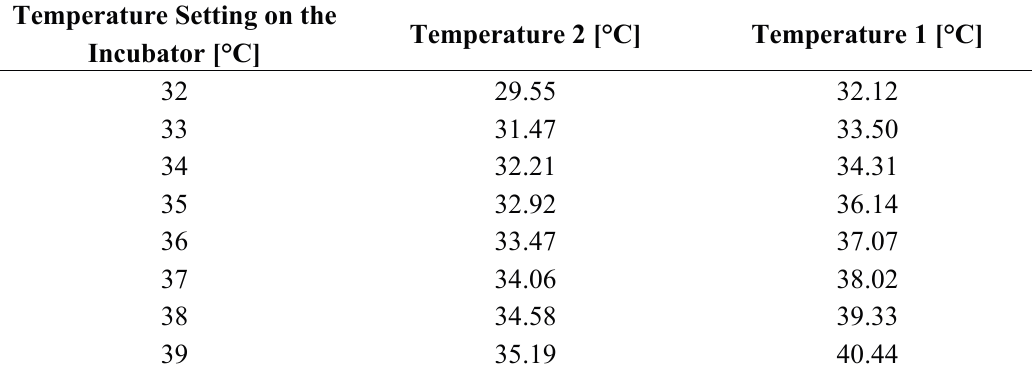
Table 3. Measured temperatures inside the